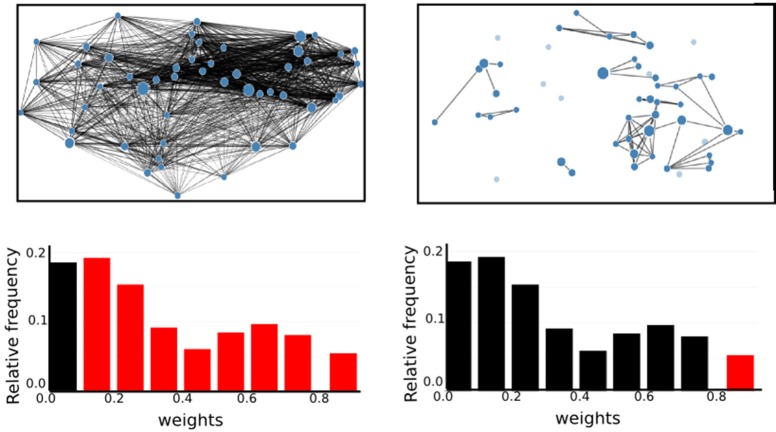
High thresholds on graph edges cause the graphs to dissociate. (Upper Panel), Illustration of graph with edge weights larger then 0.1 (wmin>0.1, Left) and larger then 0.9 (wmin>0.9, Right). In the according weight histograms (Lower Panel) the red bars correspond to the edges drawn in the upper graph. Edges corresponding to the black bars are not shown.